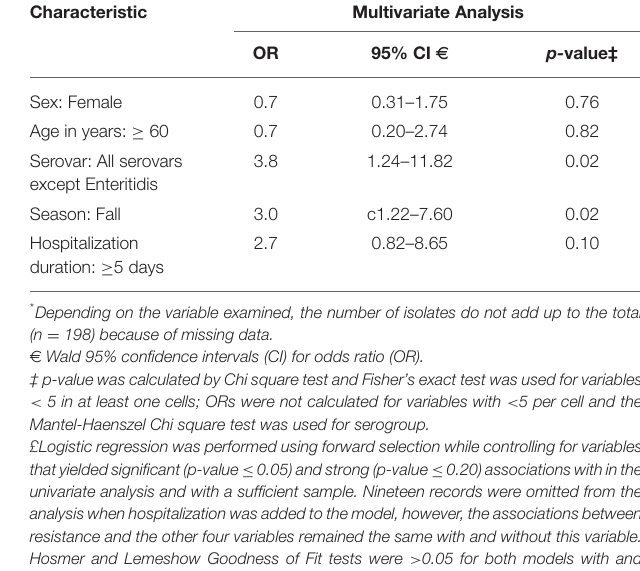
Characteristic Multivariate